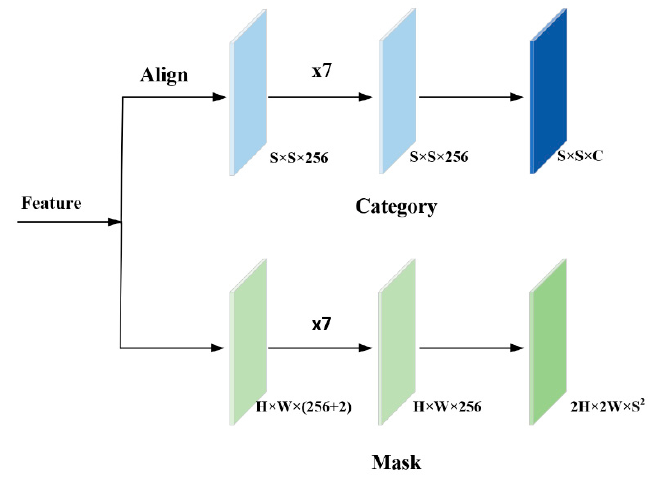
Figure 5. Detection head of SOLOv1.